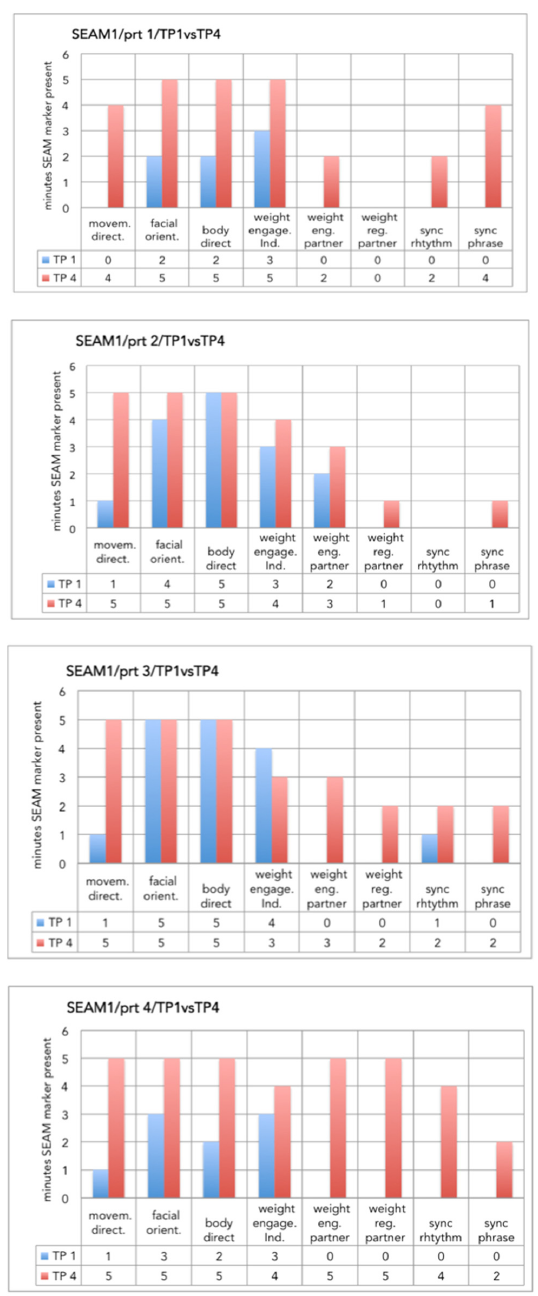
Figure A2. To show a graphical summary for all participants of the changes in scores for single SEAM categories between TP1 and TP4.